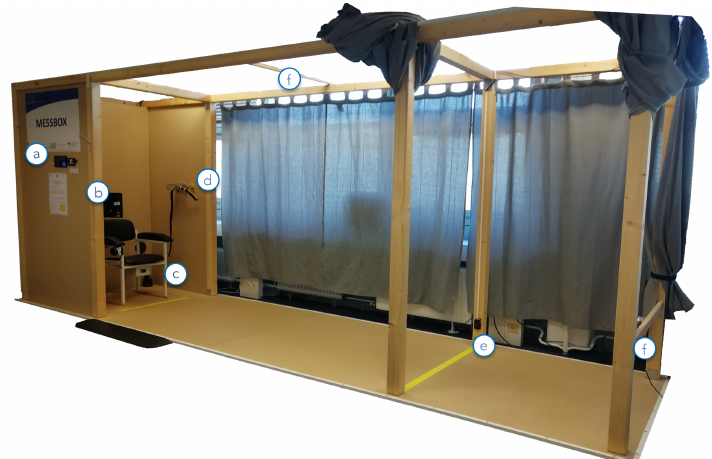
Figure 7. The evaluation prototype comprising (a) an introductory display and an RFID authenti- cation device, (b) main display for user interaction, (c) the integrated aTUG chair with additional LBs, (d) a sensor belt including an inertial sensor, (e) light barriers at 3 m walking distance, (f) Intel RealSense D435 depth image camera placed approximately 4 m from the chair at an upper level facing onto it. Image originally published in